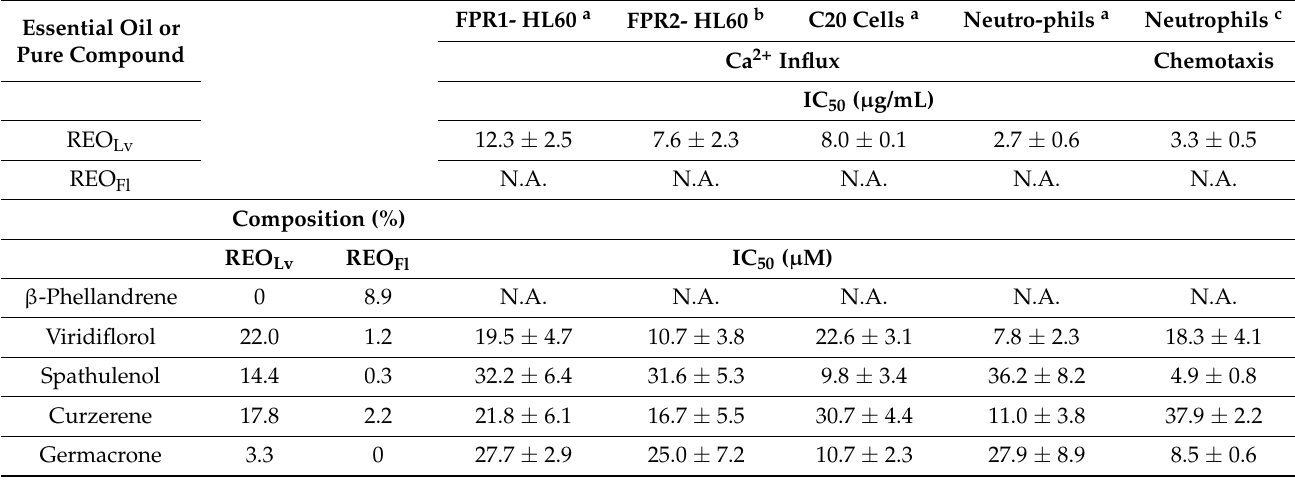
Table 5. Effect of R. albiflorum essential oils and component compounds on agonist-induced functional responses in human neutrophils and microglial cells.